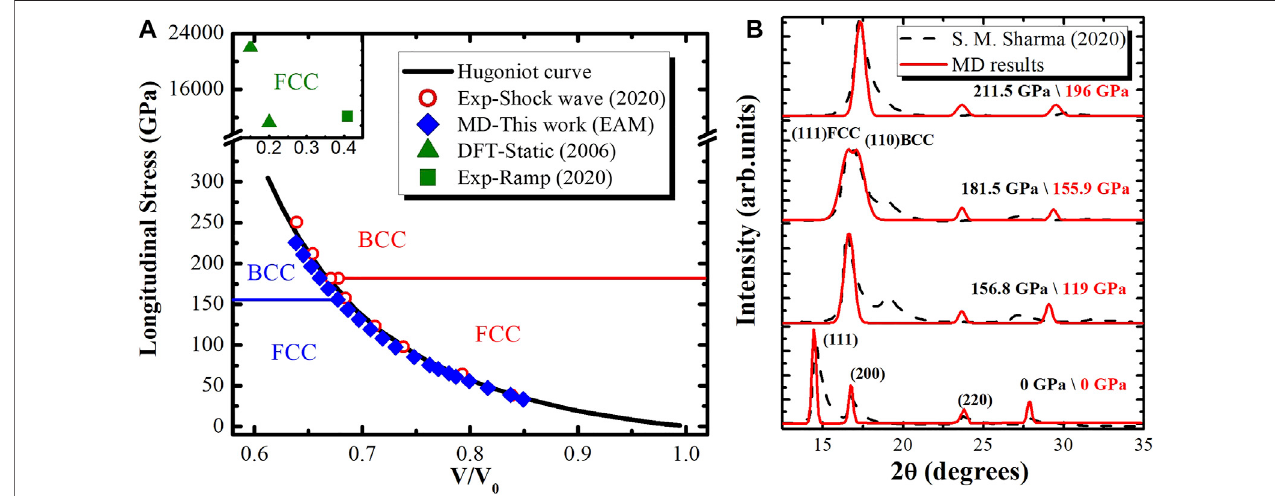
FIGURE 2 | (A) The fraction of atoms with four structural types under different shock pressure are analyzed by a-CNA. (B) The ECN distribution of atoms with corresponding structures under three typical pressure.